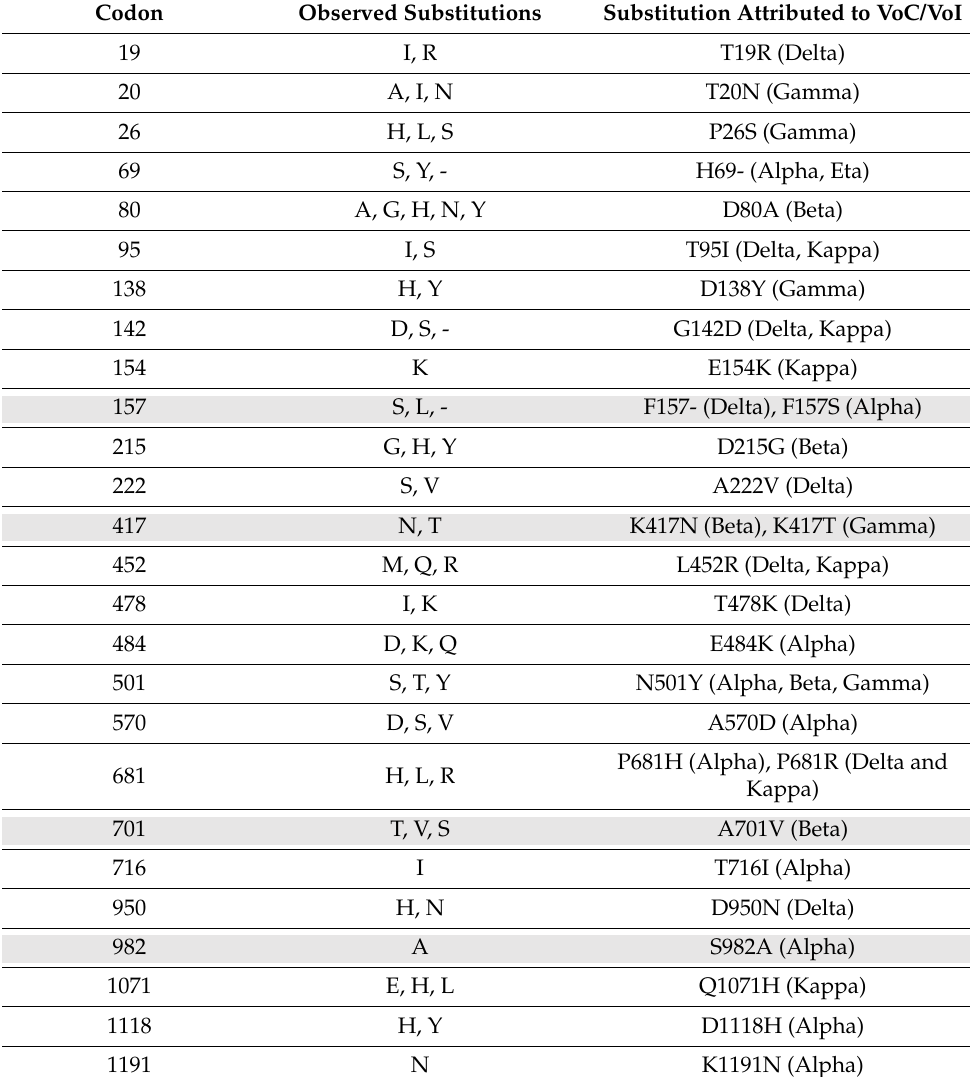
Table 2. List of sites in spike protein that are under positive selection or significantly variable, which map to substitutions sampled in VoC/VoI. Highly variable sites are shown as grey filled rows. Codon Observed